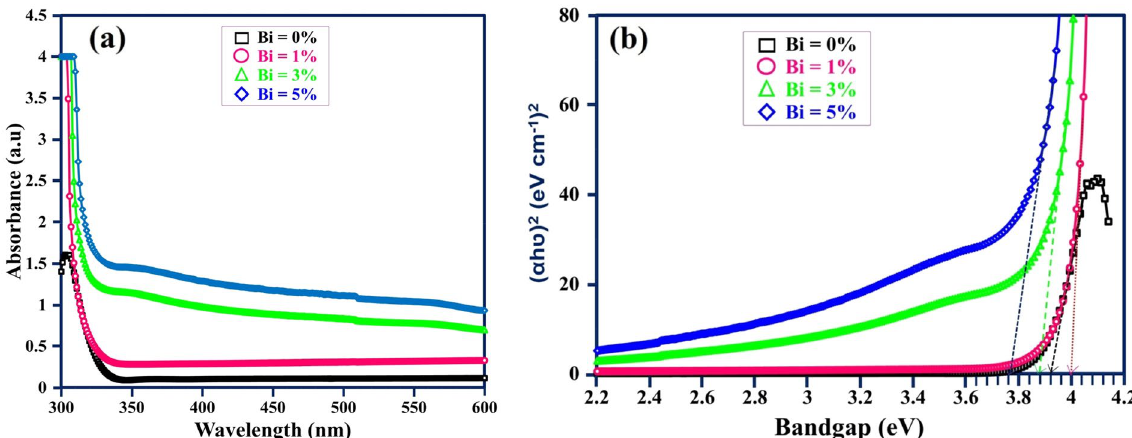
Fig. 5 a UV–vis absorption spectra of Cd Cd Zn Bi S QDs for the optical band gap 0.9-x 0.1 x